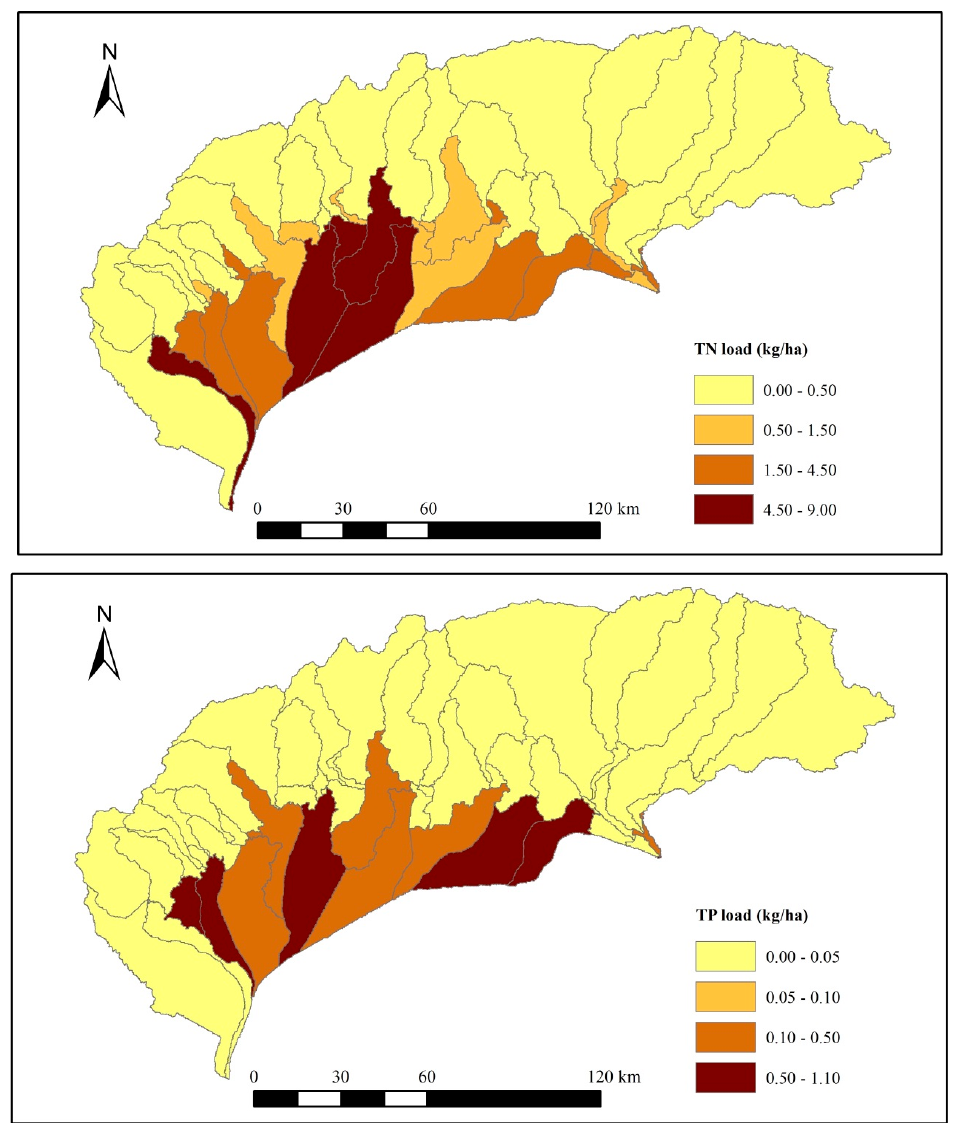
Figure 5. Map of the spatial partitioning of the TN and TP loads.